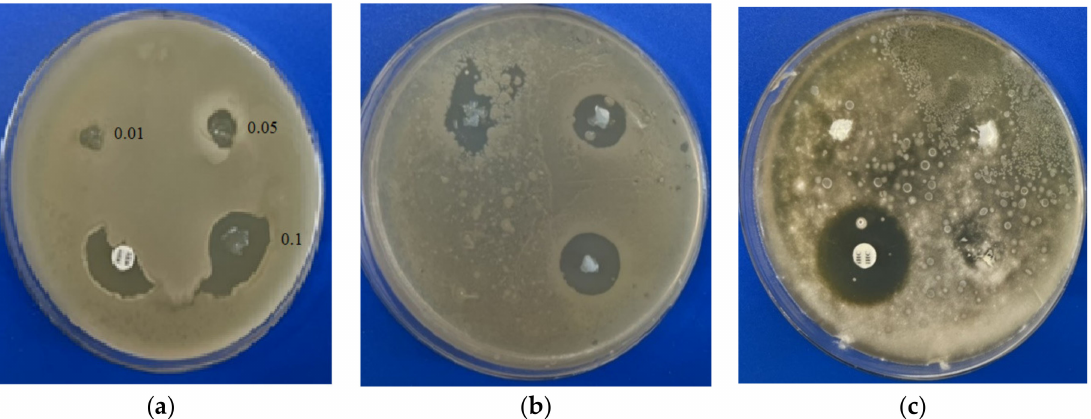
Figure 4. Antimicrobial activity of the films with different BAKCl concentrations (0.01–0.1) detected by disc diffusion method: ( a ) Staphylococcus aureus ATCC 25923; ( b ) Bacillus subtilis ATCC 6633; ( c ) Aspergillus niger ATCC